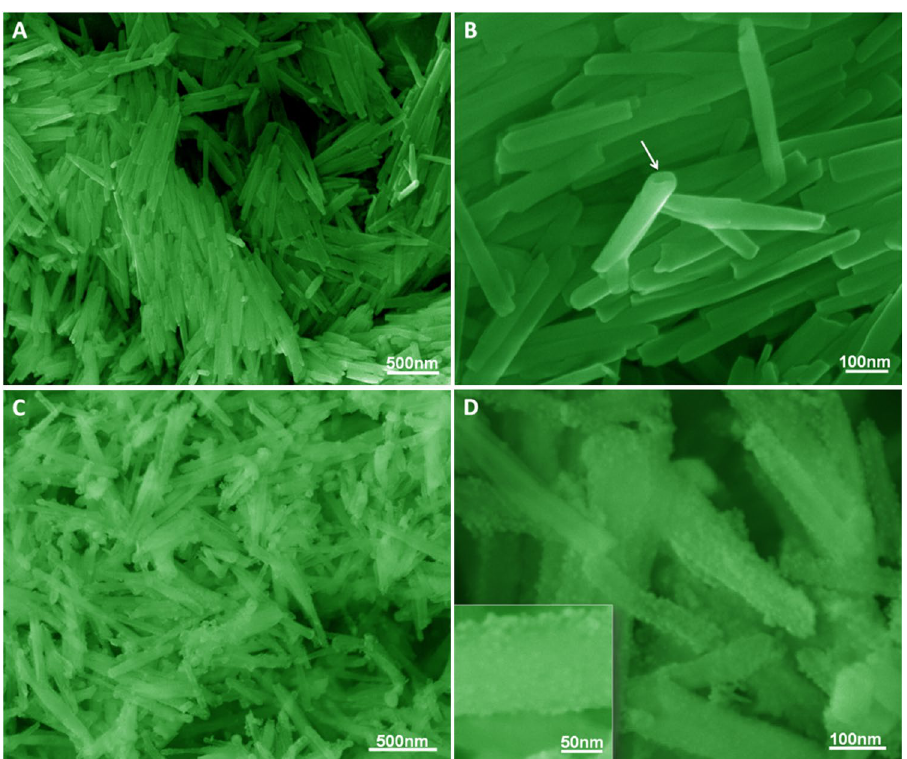
Figure 3. SEM images of ( A , B ) HNTs and ( C , D ) HNTs@ZnO nanocomposites. The inset in ( D ) shows a high- magnification SEM